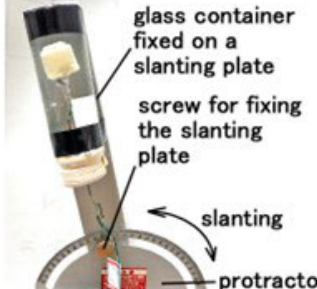
Figure 10. Posture of the equilibrium sensor mimicking a saccule for the slanting